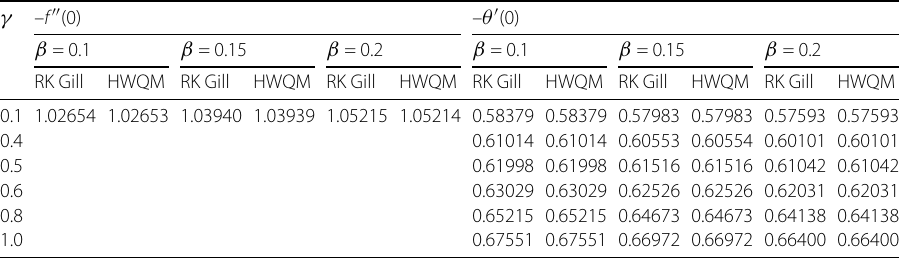
Table 2 The values of – θ (cid:5) (0) and – f (cid:5)(cid:5) (0) when Pr = 1 and s = 0 γ – f (cid:5)(cid:5)